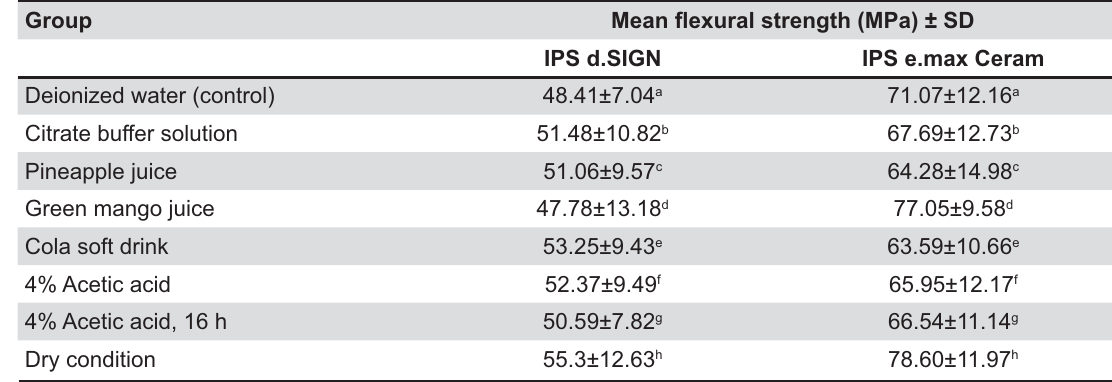
a-h (cid:2)(cid:22)(cid:5)(cid:31)(cid:4)(cid:2)(cid:12)(cid:9)"(cid:4)(cid:10)(cid:12)#(cid:10)(cid:19)"(cid:13)(cid:2)(cid:11)(cid:4)(cid:13)(cid:13)(cid:4)(cid:10)(cid:12)(cid:2)(cid:19)(cid:6)(cid:2)#(cid:20)(cid:11)(cid:9)(cid:31)(cid:6)(cid:12)(cid:2)(cid:19)(cid:6)(cid:17)(cid:19)#(cid:5)(cid:13)(cid:4)(cid:2)(cid:6)(cid:20)(cid:2)(cid:12)(cid:19)(cid:14)(cid:6)(cid:19)$#(cid:5)(cid:6)(cid:13)(cid:2)(cid:17)(cid:19)(cid:25)(cid:25)(cid:4)(cid:10)(cid:4)(cid:6)#(cid:4)(cid:2)(cid:21)&(cid:9)’(cid:4)*/(cid:12)(cid:2);(cid:22)(cid:23)(cid:2)(cid:13)(cid:4)(cid:12)(cid:13)<(cid:2) α =0.05).